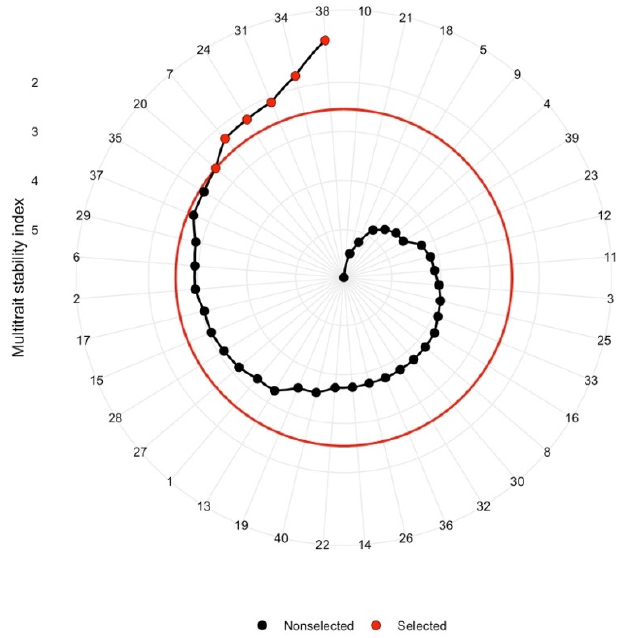
Figure 5. MTSI indices of tested genotypes based on Milk ha − 1 and Milk t − 1 jointly considered with stability of the traits; selected genotypes at 15% selection intensity are marked in red.